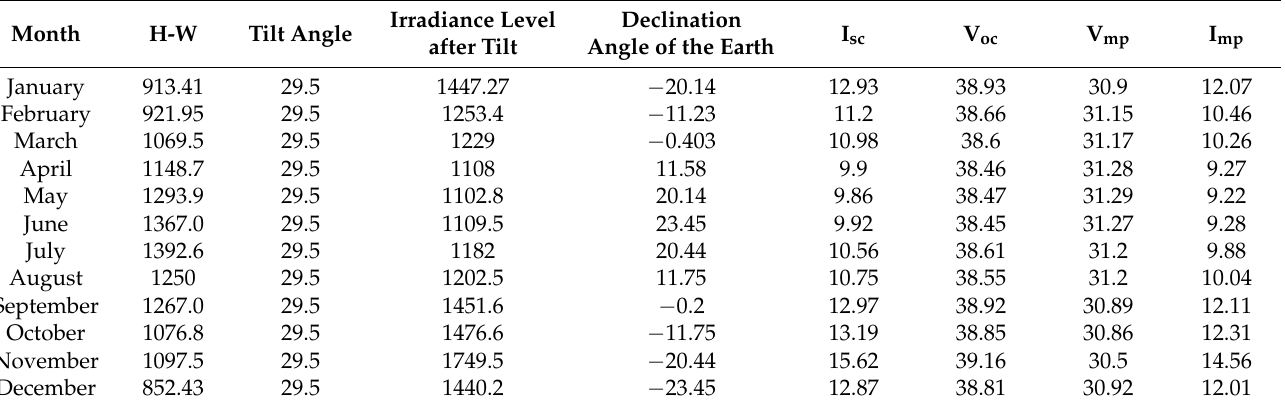
Table 4. Monthly specific daily global irradiance (H), optimal tilt angle (deg), declination angle of the